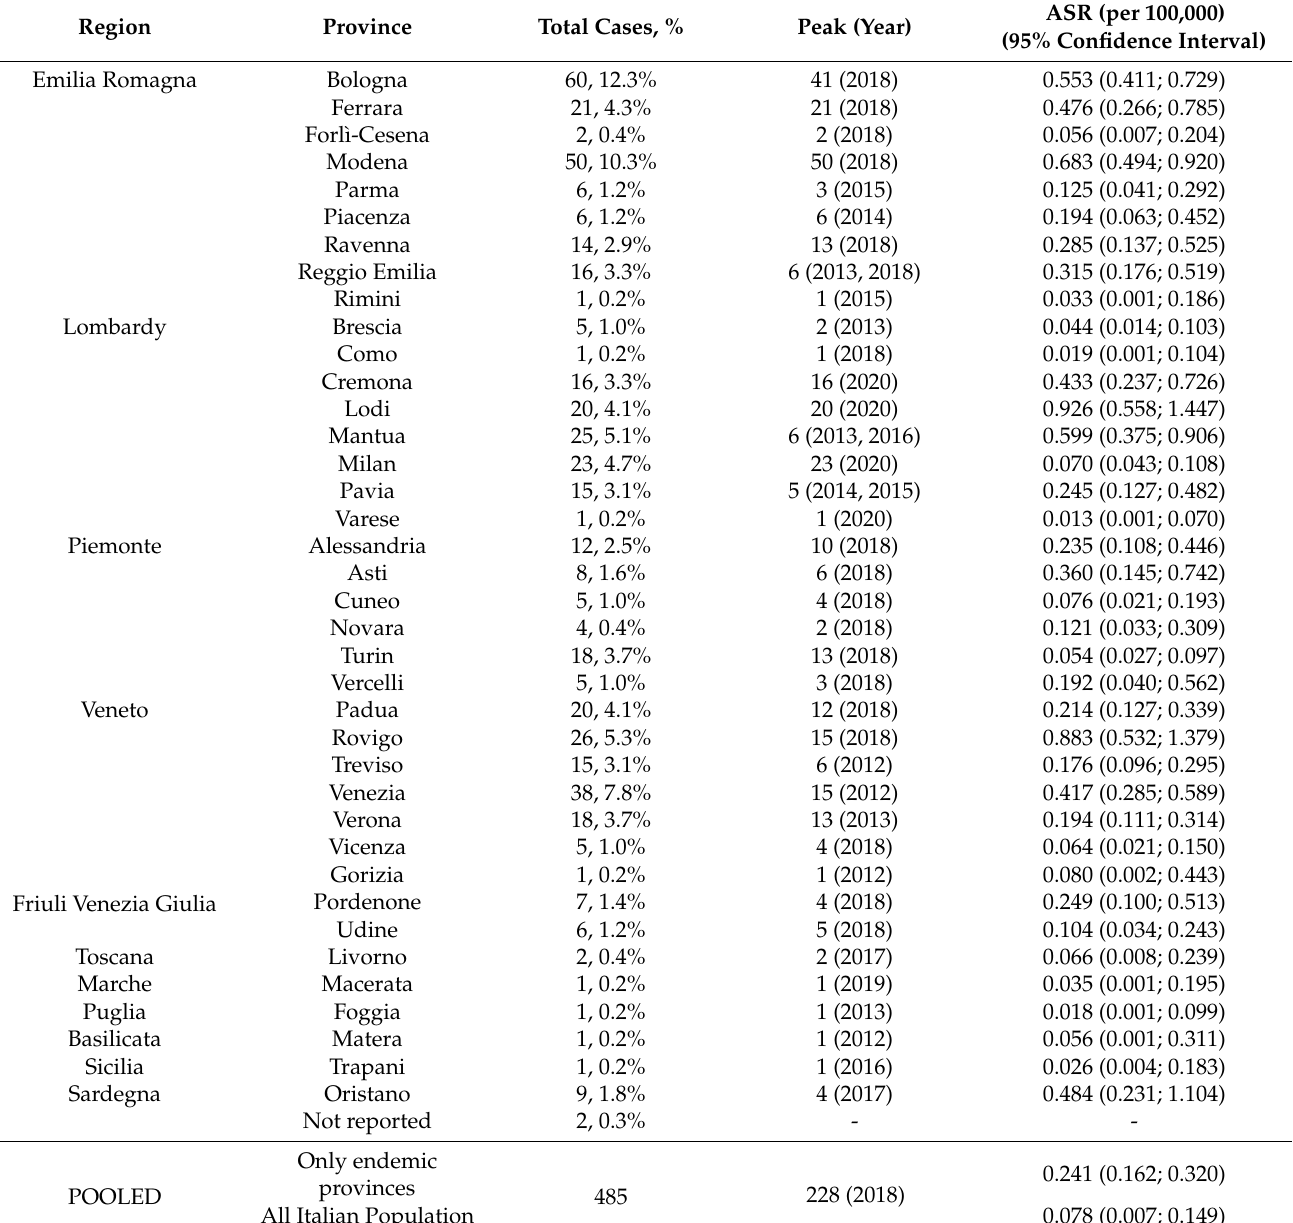
Table 3. Epidemiology of West Nile neuro-invasive disease (WNND) in Italy (2012–2020) by province of diagnosis. Age standardized incidence rates (ASR) and their corresponding 95% confidence intervals were calculated based on the standard European